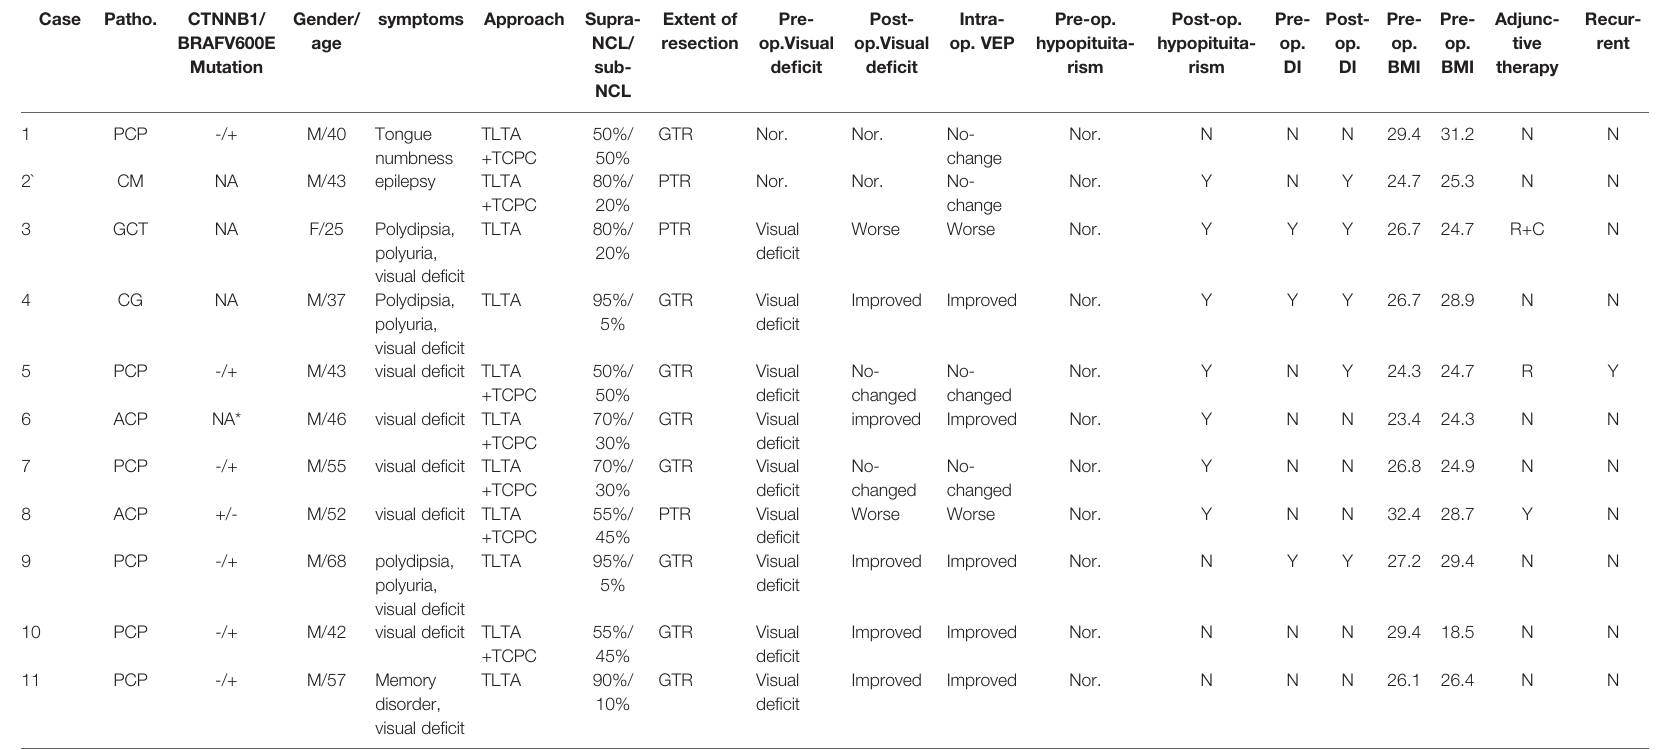
TABLE 1 | Clinical data of tumors extended into third ventricle. Case